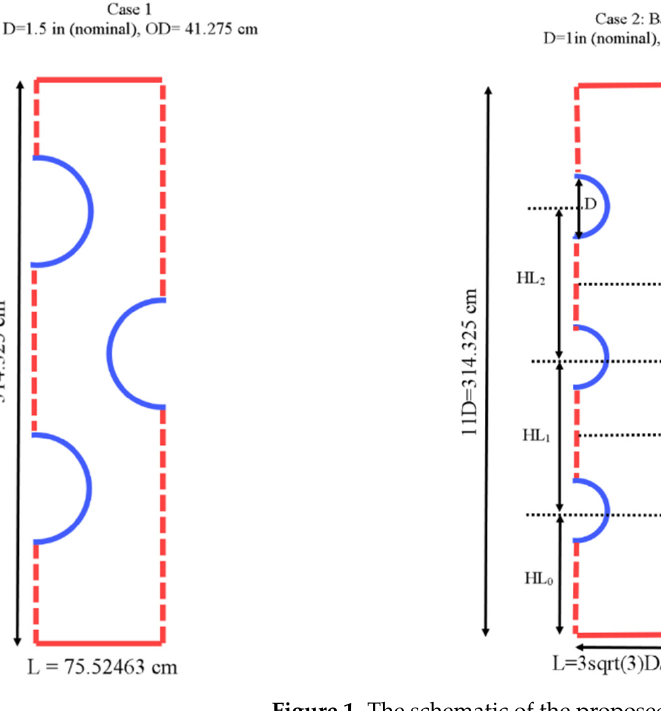
Figure 1. The schematic of the proposed multitube heat exchanger. Three different diameters are considered for the tubes in different systems while the RT-35 from Rubitherm company is used as the PCM in this study. The properties of total area of the tubes is considered constant. Thus, the masses of the PCM in the systems RT35 are presented in Table 1. are similar. The nominal diameters of the tube (D) are 0.5 in, 1 in, and 1.5 in and thus the outer diameters of tubes are 15.875, 28.575, and 41.275 mm. Note that the tubes are selected from the standard sizes of copper tubes in heat exchangers. The height of the shell Table 1. Thermophysical properties of RT35 [61] . is assumed to be 314.325 mm, and the width of each repeated section is considered to be 71.344 mm which are selected based on the system with five tubes as shown. It is